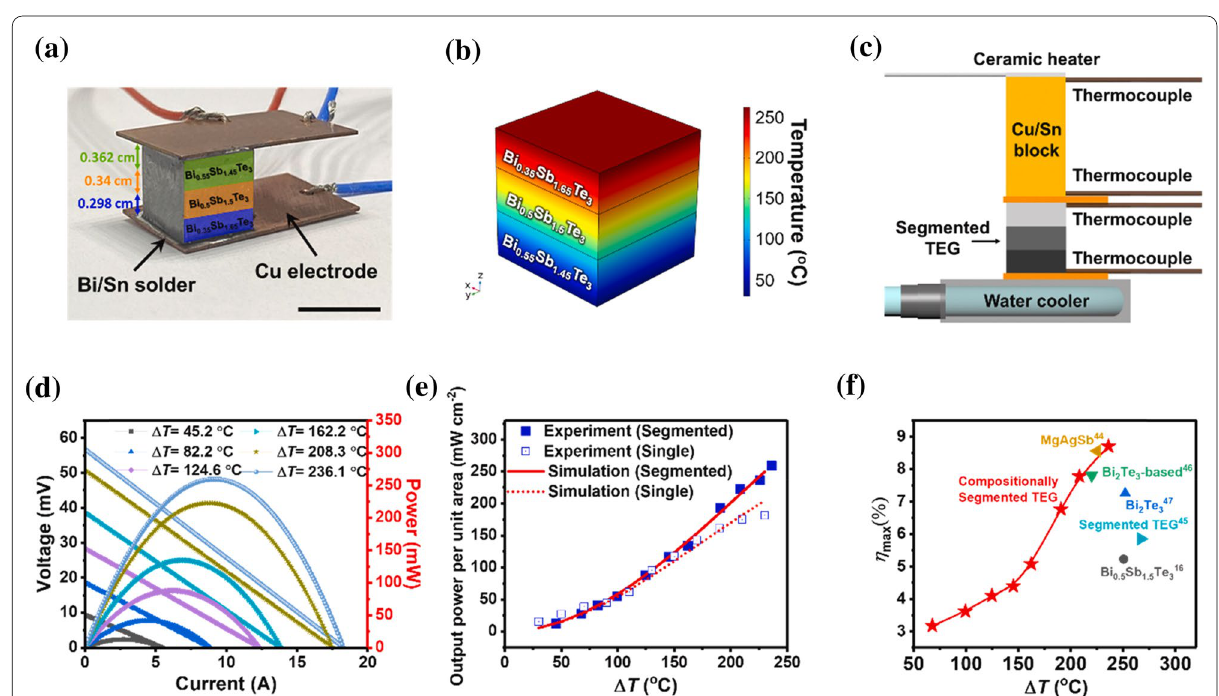
Fig. 11 a A 3D printed compositional three-block BiSbTe thermoelectric generator b temperature gradient along the TEG layers evaluated by simulations c testing schematic to experimentally measure the output power and energy conversion efficiency of TEG d the output power and voltage of the proposed TEG at varying temperature difference e comparison of the simulated and experimentally measured power densities of the TEG as a function of the applied temperature difference f trend of energy conversion efficiency with ΔT [35] (Images are re-used with the permission of the publisher)